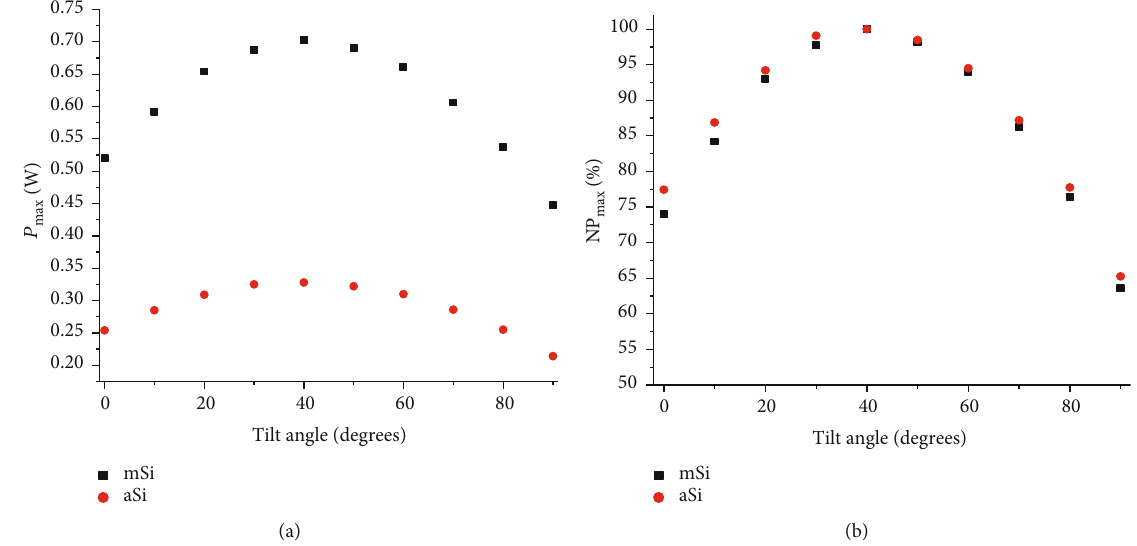
Figure 2: Performance comparison of the PV panels vs. tilt angle: (a) the maximum power and (b) the normalized power. 00.20.40.60.811.2